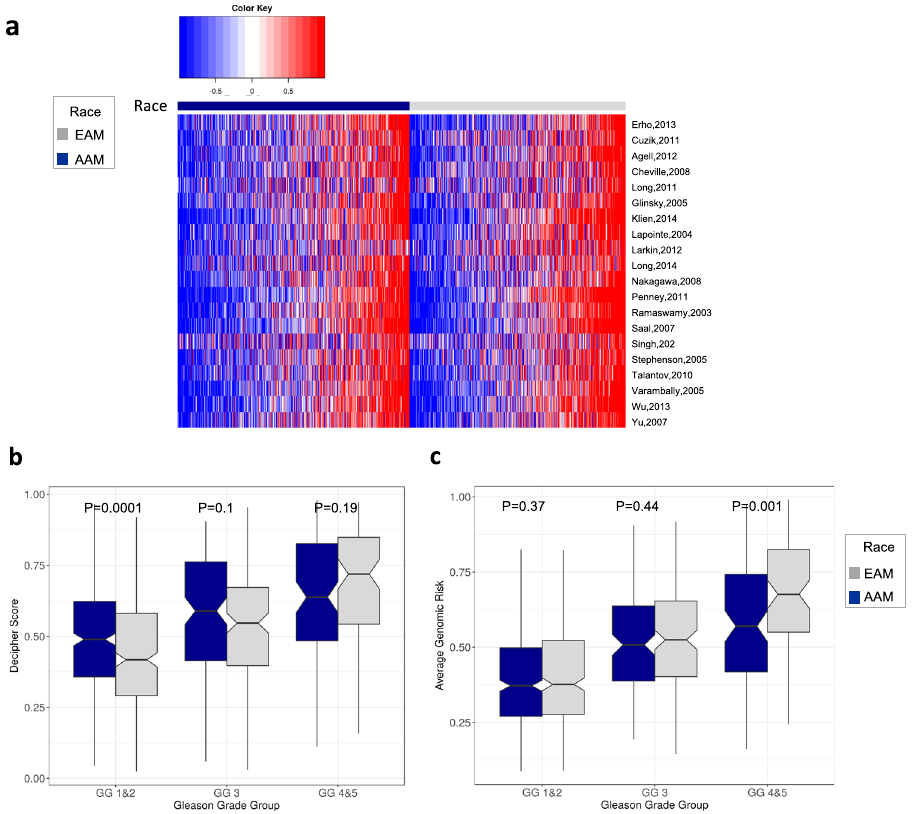
Fig. 1 Comparison of genomic-risk signatures and their grade group associations in AAM and EAM. a Prognostic differences in AAM vs. EAM. 20 prognostic signatures show similar trends in both groups. Overall, both Decipher ( b ) and average genomic-risk scores ( c ) positively correlate with grade groups in both races. b Decipher is higher in AAM with low grades but not different in high-grade tumors. c In contrast, average genomic risk is lower in the AAM with high-grade tumors. AAM African-American men, EAM European-American men. Error bars represent the 95% con fi dence